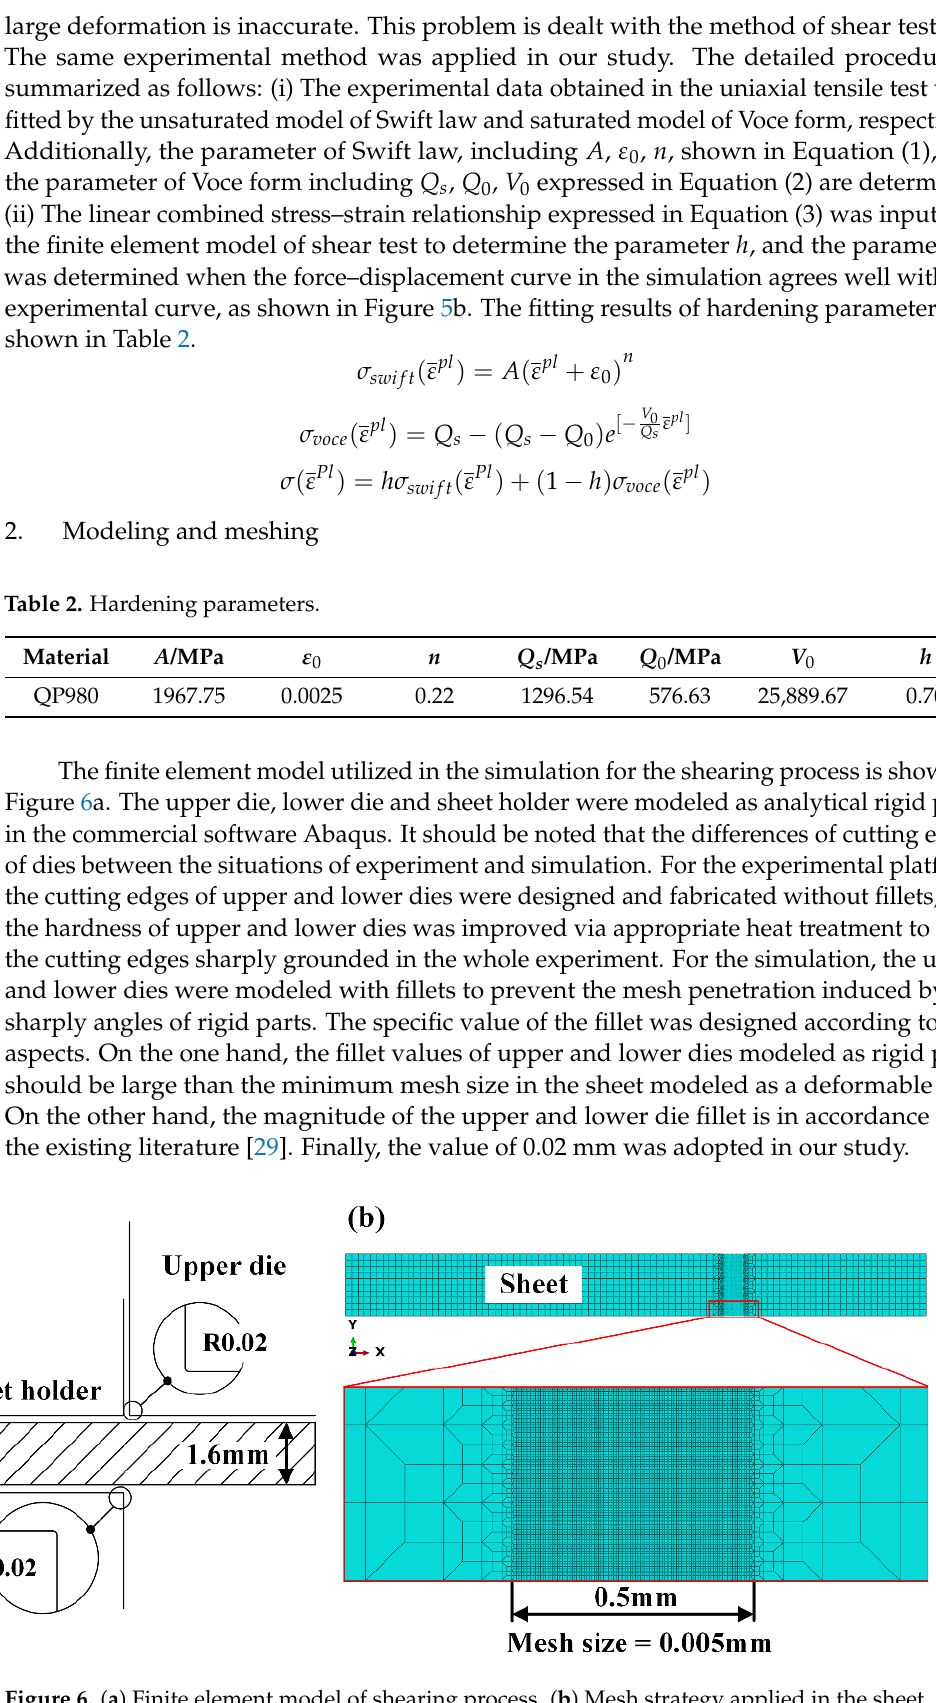
Figure 6. ( a ) Finite element model of shearing process. ( b ) Mesh strategy applied in the sheet. To reduce computation time and improve calculation accuracy at the same time, the local mesh refinement method is employed in the meshing for the sheet part, as shown in Figure 6b. The region far away from the shearing deformation zone was meshed into ten layers along the thickness direction with the size of 0.16 mm in each layer, which is accu- rate enough in the simulation for sheet forming without fracture. For predicting the mor- phology of the sheared edge, the range of mesh refinement was set to cover the width of the whole crack generated in the shearing process. The critical region’s fracture behavior was meshed at the size of 0.005 mm in the range of 0.5 mm, as shown in Figure 6b, which was determined after several simulation attempts. 3. Ductile fracture criteria Six widely used uncoupled ductile fracture criteria are selected to simulate the shear- ing process of QP980 steel. The simulation results are compared with the corresponding experiment results to determine the optimum ductile fracture criterion. The ductile frac- ture criteria used in our study are listed in Table 3. Table 3. Summary of ductile fracture criteria used in the research. Ductile Fracture Criteria